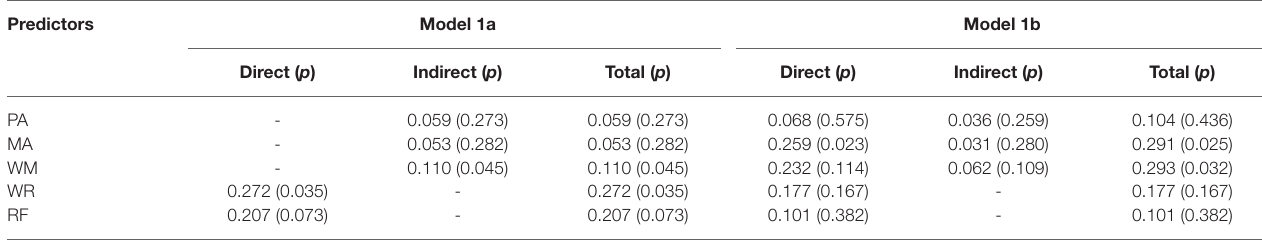
TABLE 5 | Standardized direct, indirect, and total effects of predictors on reading comprehension, in the full mediation (1a) and partial mediation (1b) models. Predictors Model